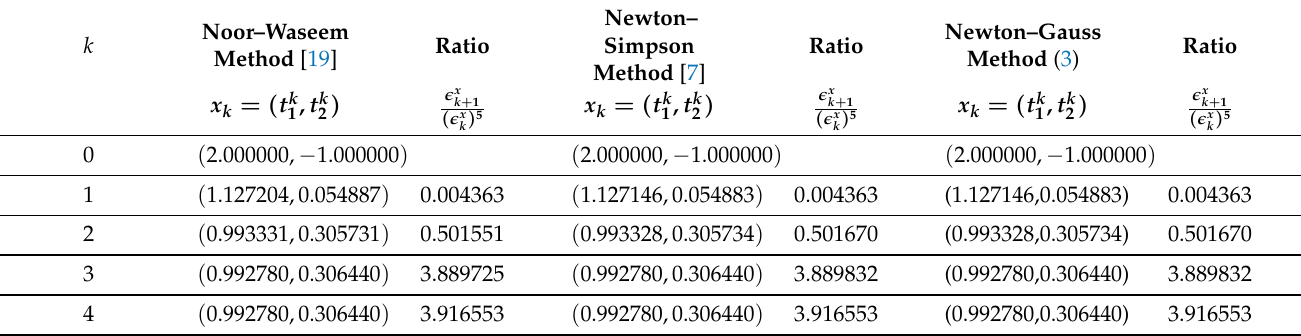
Table 2. Methods of order